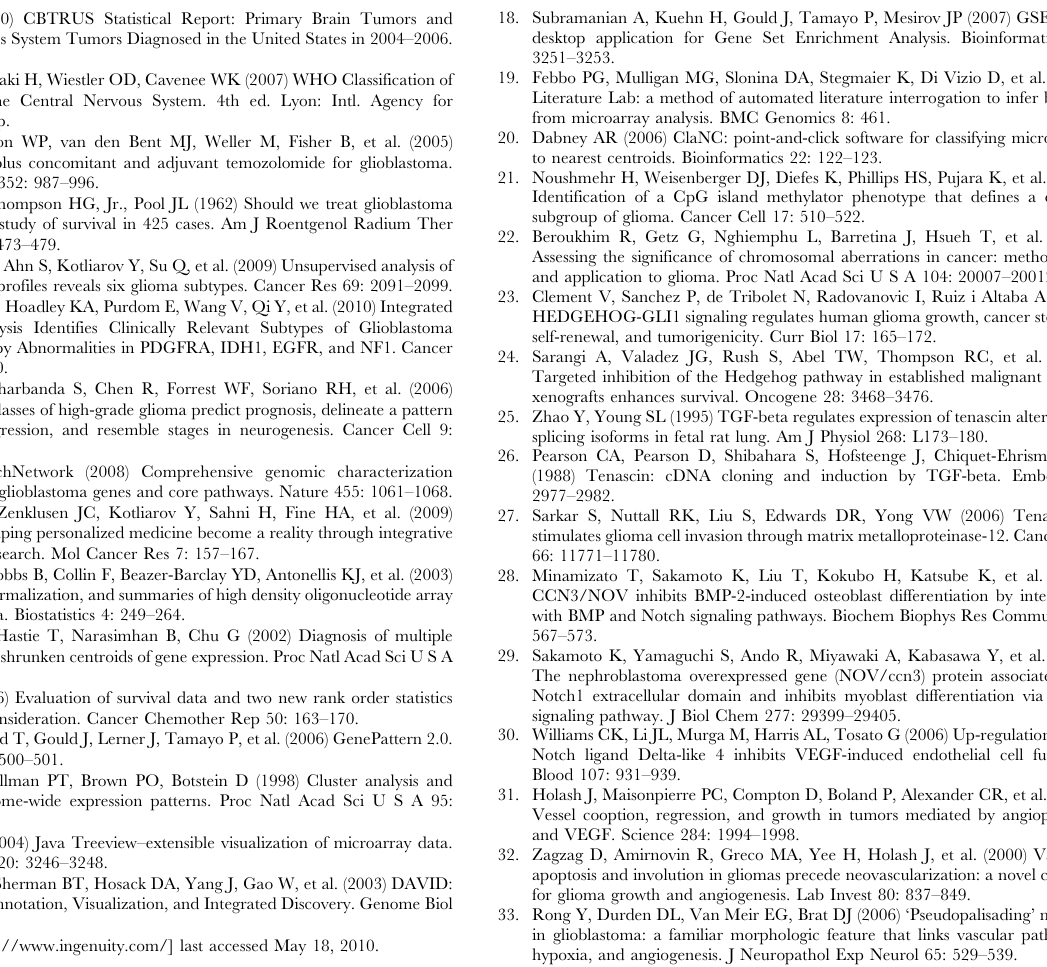
Figure S1 Kaplan-Meier Analysis of Low-grade